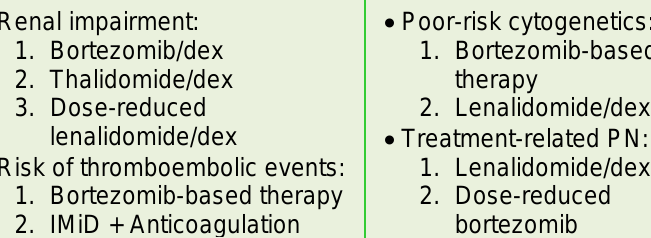
1. Lenalidomide/dex 2. Dose-reduced